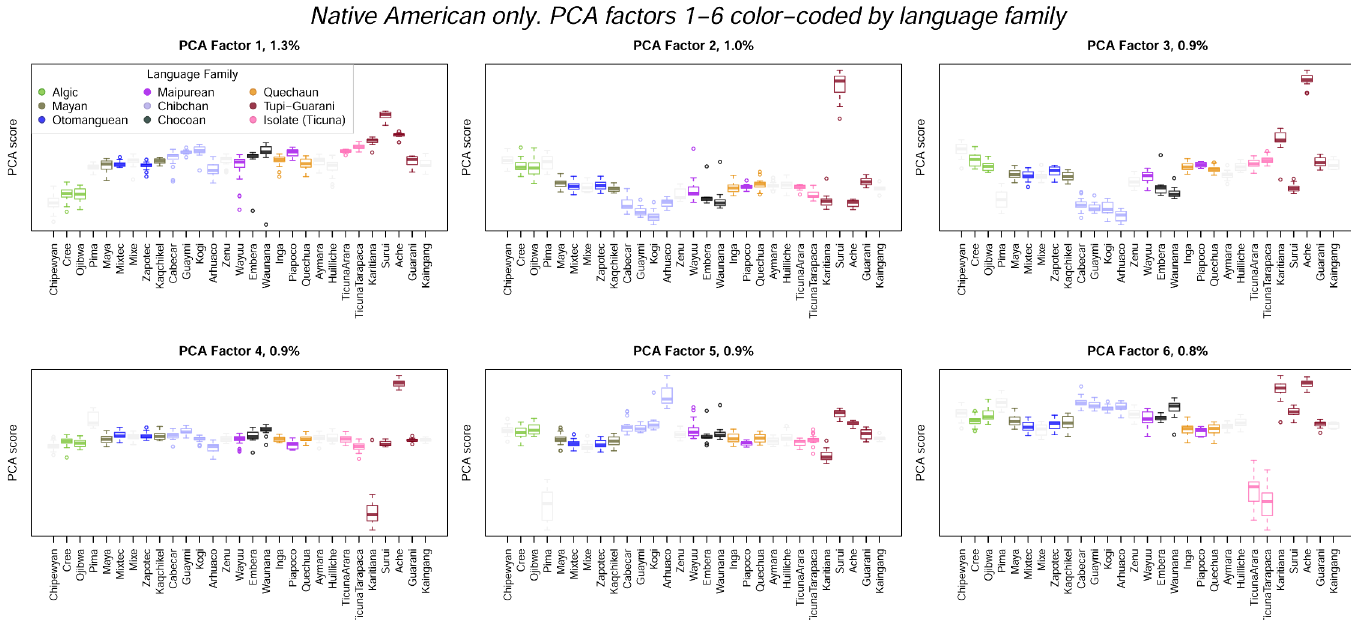
Fig 7. Boxplots of PCAs 1 – 6 for analyses of the Native American populations alone, color-coded by language